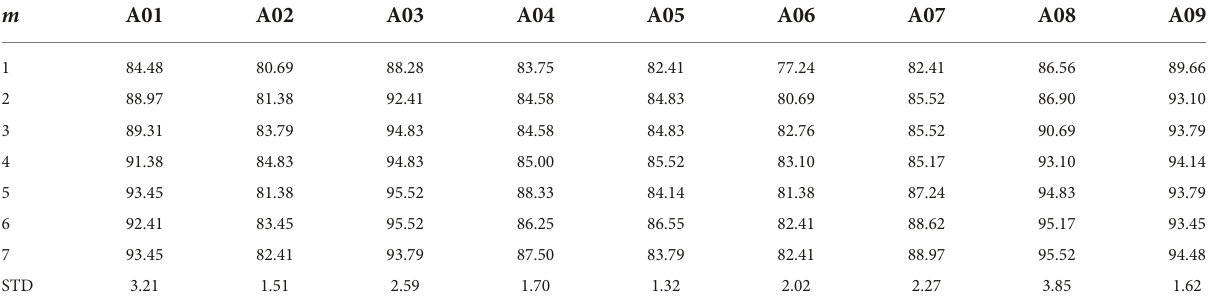
TABLE 7 Performance comparison of different values of m for our method, using dataset 1.